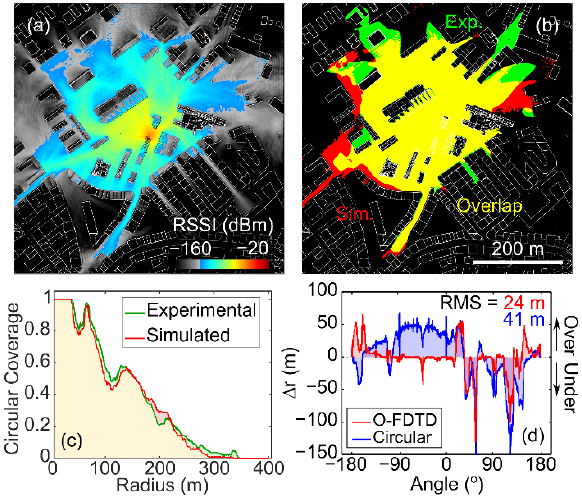
Fig. 3 . Cityscape LoRa Propagation. (a) Simulated RSSI map. (b) Simulation versus experimental coverage areas. Quantitative area (c) and (d) edge comparison (modified from [3]).